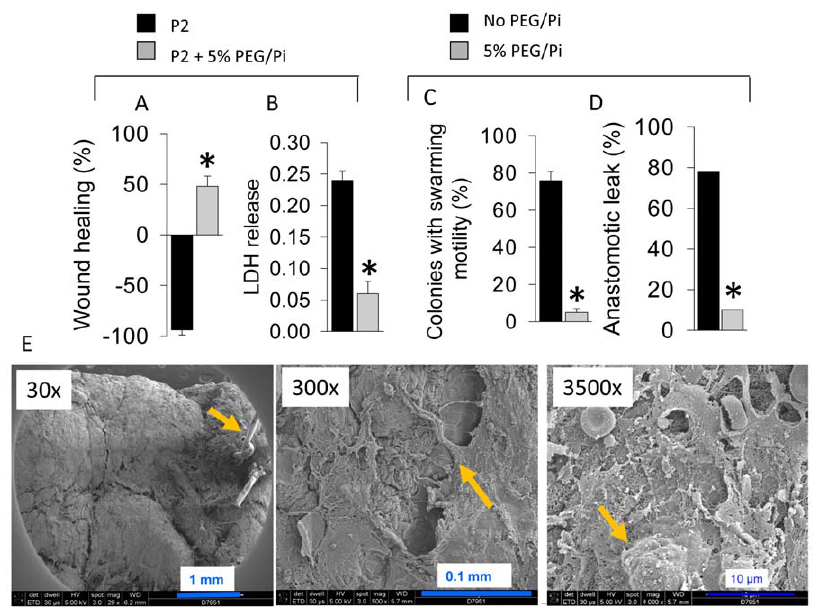
Figure 7. Protective effect of PEG/Pi. (A) Inhibition of wound apposition (healing) by P. aeruginosa MPAO1-P2. n=5, *p , 0.01. (B) Prevention of the cytotoxic effect of MPAO1-P2. n=6, *p , 0.01. (C) Frequency of transformation MPAO1 to P2 phenotype. n=3, *p , 0.01. (D) Frequency of anastomotic leak in rats. n=10, *p , 0.01. (E) SEM images of anastomotic tissues treated with 5% PEG/Pi demonstrating intact intestinal epithelium covered with a mucus-like film structure.